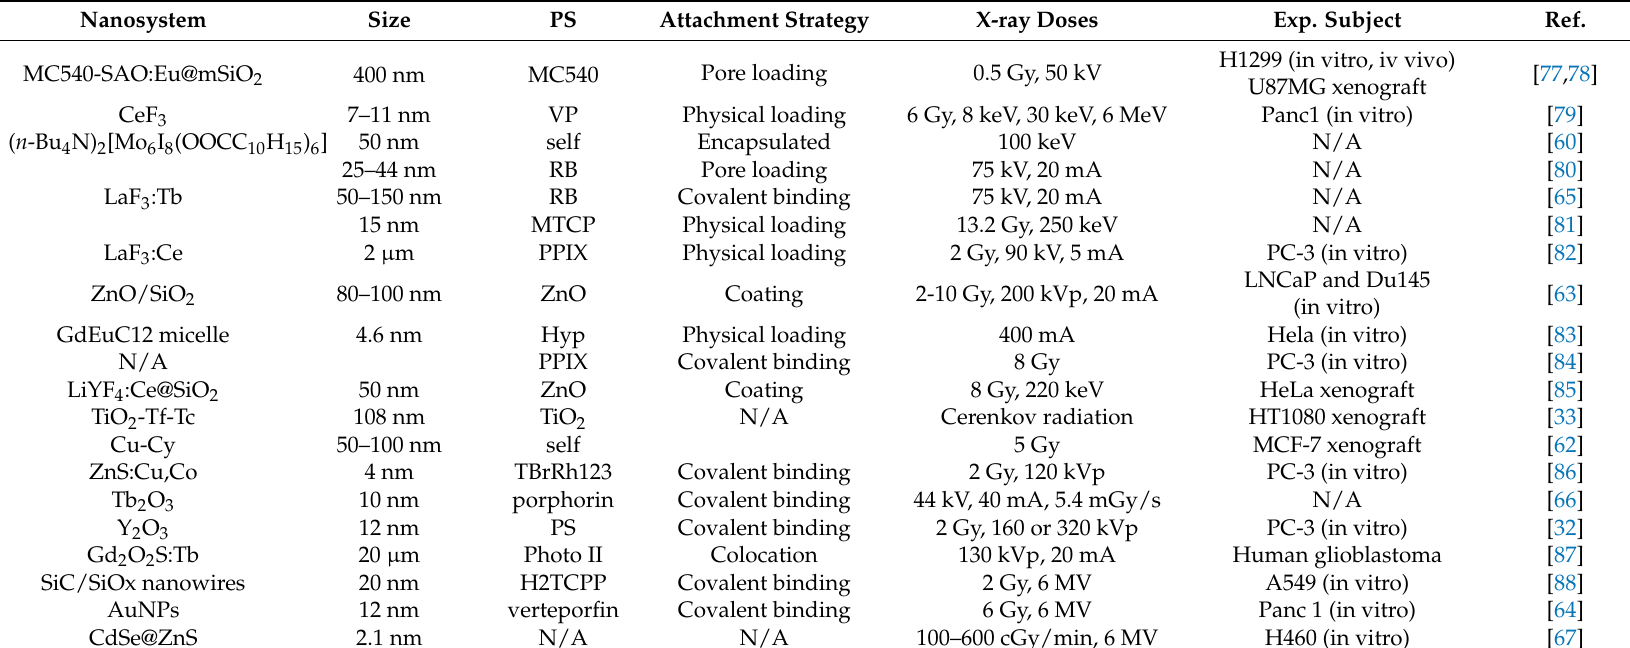
Table 2. Depth limitless X-ray scintillators for cancer